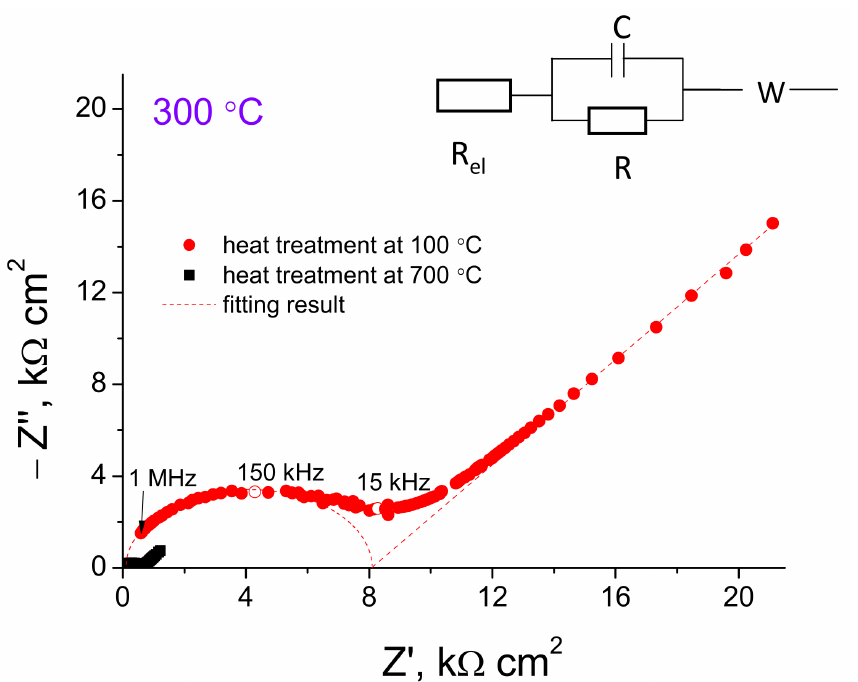
Figure 10. Impedance plots of Li 4 Ti 5 O 12 | c -LLZ half-cells after heating at 100 and 700 ◦ C.